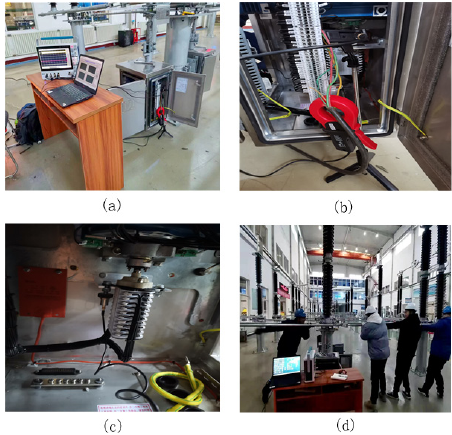
Figure 8. ( a ) Operating mechanism box and pictures collected on site. ( b ) The installation position of the current clamp. ( c ) The installation position of the vibration sensor at the auxiliary switch screw. ( d ) Artificial simulation of the jamming fault.